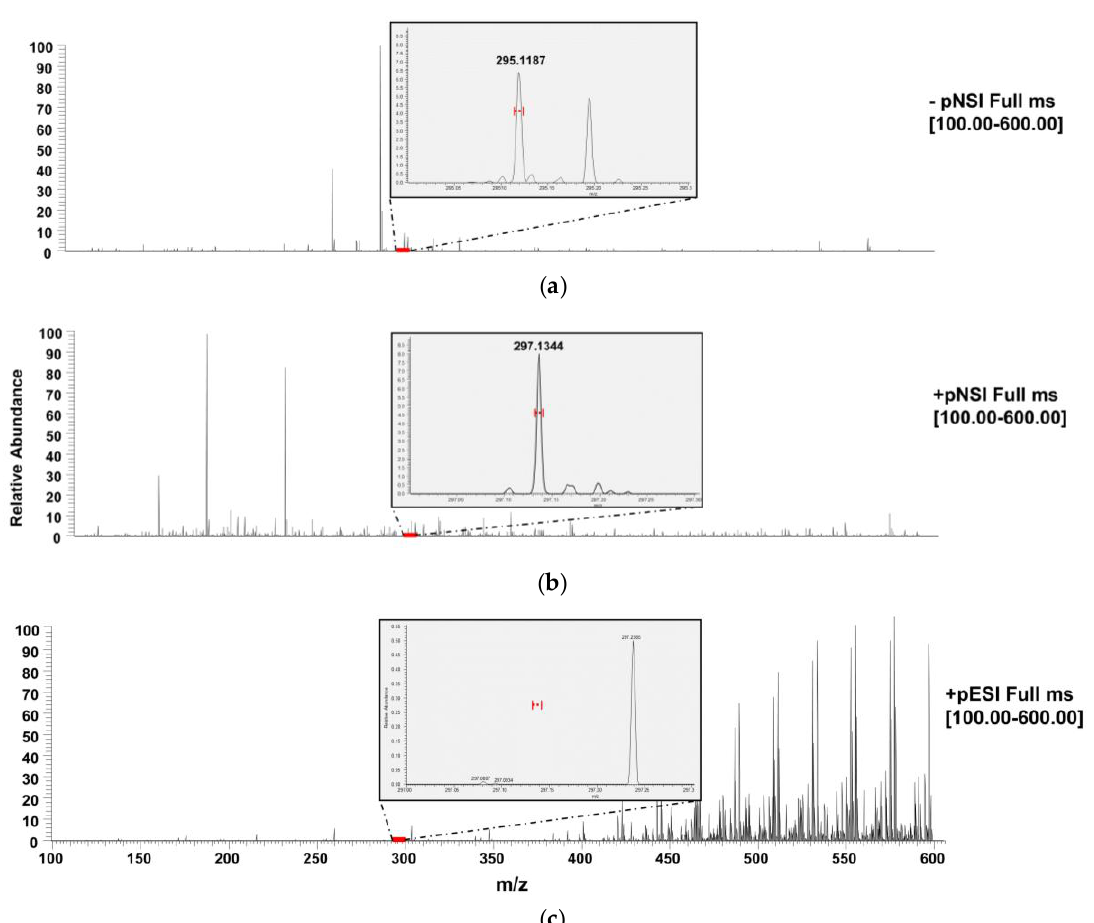
Figure 2. Comparison between full scan ( m/z 100–600) mass spectra of a MeOH/NH 3 2% v/v solution of DON containing 10% v/v LFIA assay running buffer in ( a ) negative and ( b ) positive ion mode in DART-Orbitrap-MS and ( c ) positive ion mode in ESI-Orbitrap-MS. Inserted are the regions of deprotonated and protonated ions of DON, and marked in red are the expected m/z regions for the ions at 5 ppm mass accuracy.